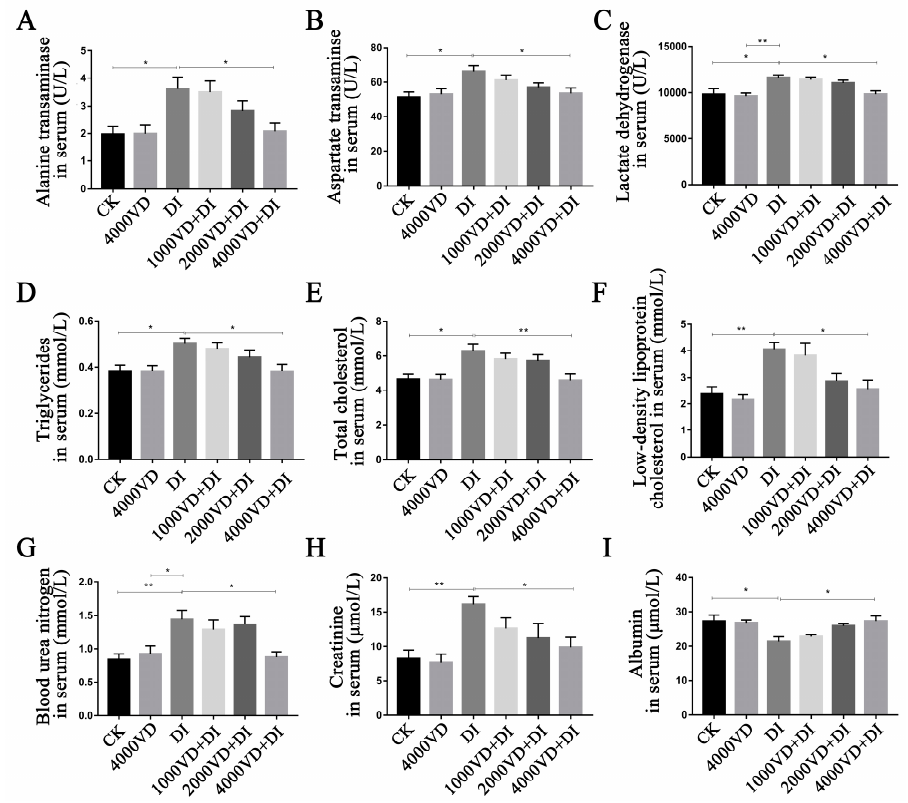
Figure 7. Effects of different levels of VD 3 supplementation on serum biochemical indexes of the Wenchang chicken oxidative stress model. ( A ) ALT activity in the serum of each group, ( B ) AST activity in the serum of each group, ( C ) LDH activity in the serum of each group, ( D ) TG content in the serum of each group, ( E ) T-CHO content in the serum of each group, ( F ) LDL-C content in the serum of each group, ( G ) BUN content in the serum of each group, ( H ) CR content in the serum of each group, ( I ) ALB content in the serum of each group. (Statistical analysis of the data was performed using the Duncan method to analyze the significance of differences between samples by IBM SPSS software, * p < 0.05, ** p < 0.01).